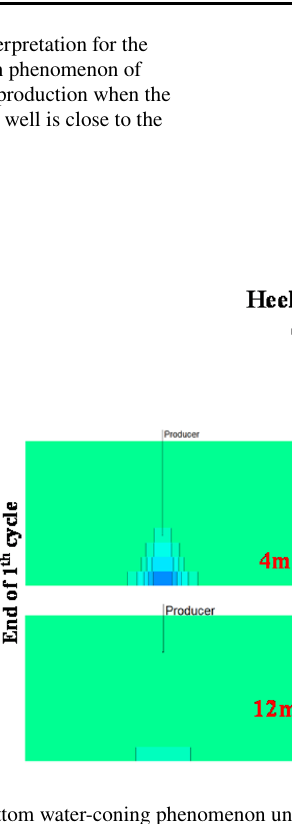
Fig. 7 Bottom water-coning phenomenon under different distance from horizontal well to bottom water condition